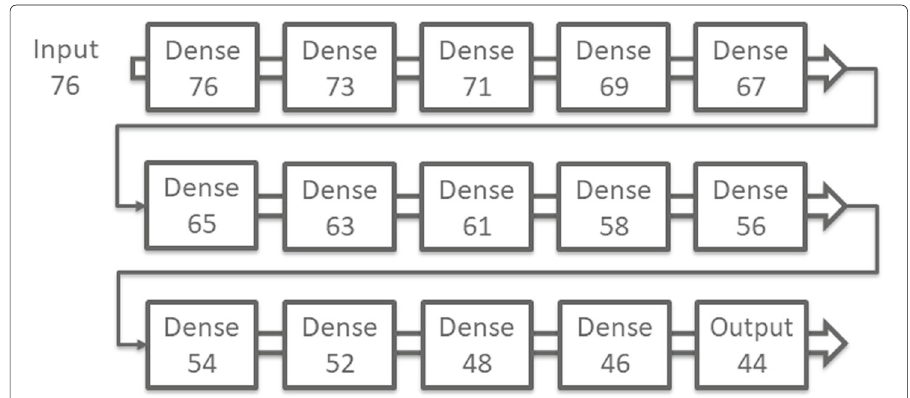
Fig. 11 Architecture of the neural network after the training process with random-based hyper parameter tuning and cross validation. The model consists of fourteen hidden layers. The 76 inputs are all P-Q pairs for the loads. Outputs are voltage values for 44 buses